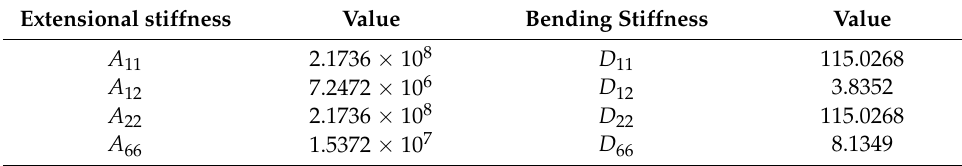
Table 3. Membrane and bending stiffness coefficients.